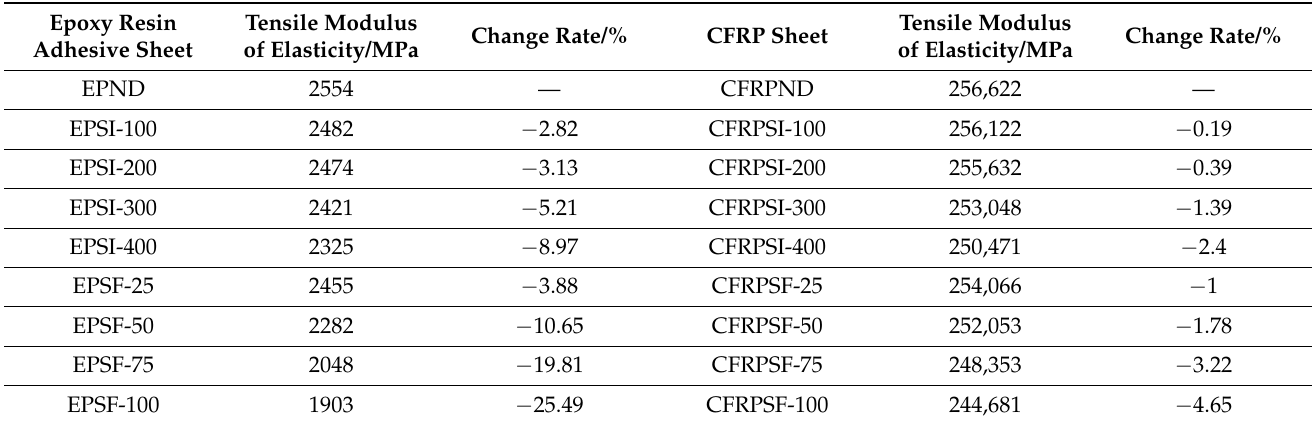
Table 7. Tensile modulus of elasticity of epoxy resin and CFRP